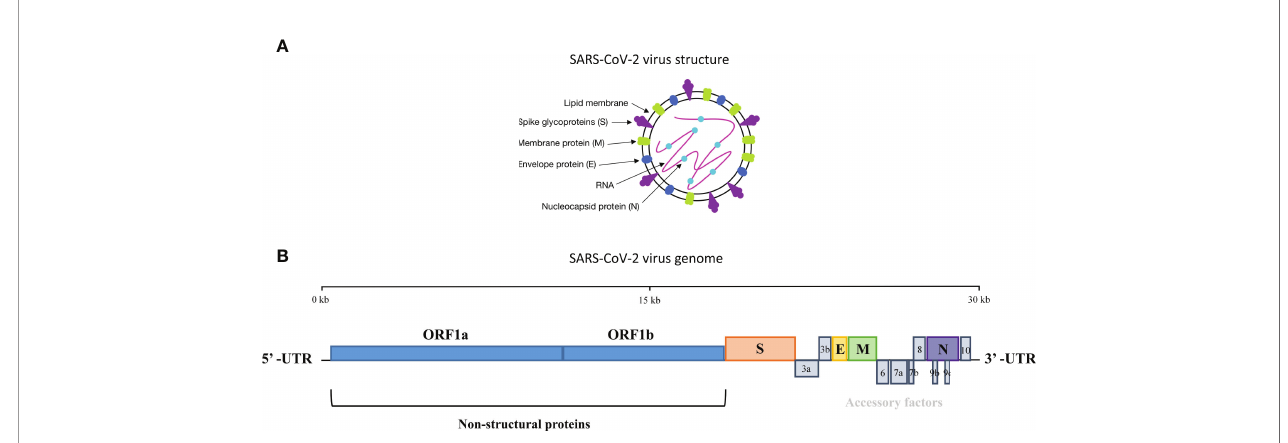
FIGURE 1 | The structure and genome organization of SARS-CoV-2. (A) Four structural proteins in SARS-CoV-2 are the spike (S), envelope (E), nucleocapsid (N) and membrane (M). S, E and M are embedded in the lipid bilayer envelope while RNA are coated by N. (B) The genome of SARS-CoV-2 consists of 13-15 open reading frames and encodes protein which plays important role in binding and translation between the virus and the host